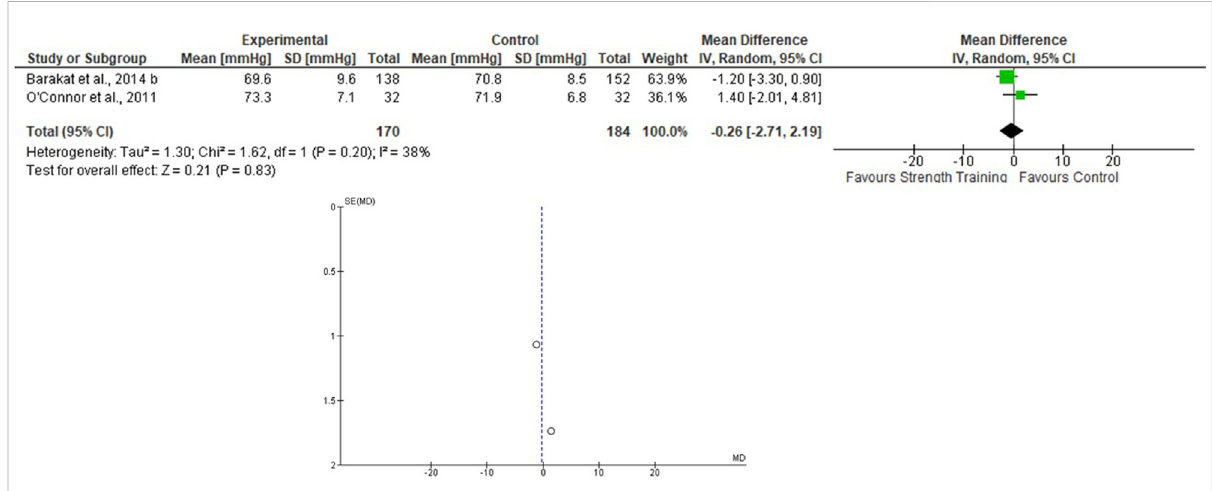
FIGURE 5 Effects of the ST on SBP in pregnant women and funnel plot for detecting bias and heterogeneity.